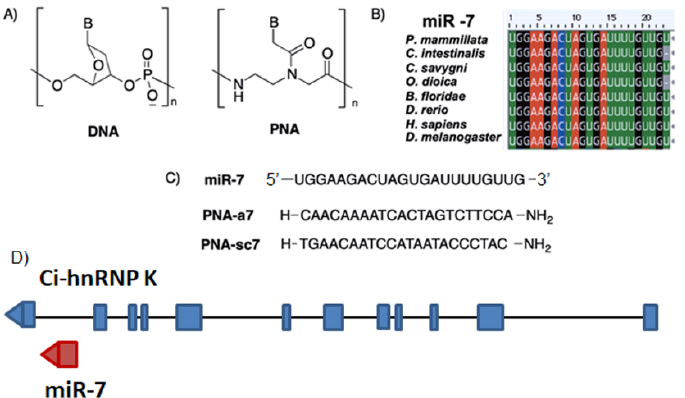
Figure 1. ( A ) DNA and Peptide Nucleic Acids (PNA) backbone; ( B ) multi-alignment of mature miR-7 sequences in di ff erent species: Phallusia mammillata , Ciona intestinalis , Ciona savignyi , Oikopleura dioica , Branchiostoma floridae , Danio rerio , Homo sapiens , Drosophila melanogaster ; ( C ) miR-7 and PNAs sequences used in this study; ( D ) schematic representation of miR-7 genomic position inside the last Ci-hnRNP K intron (blue rectangles and interconnecting lines represent exons and introns, respectively; the red graph corresponds to the miR-7 sequence) .